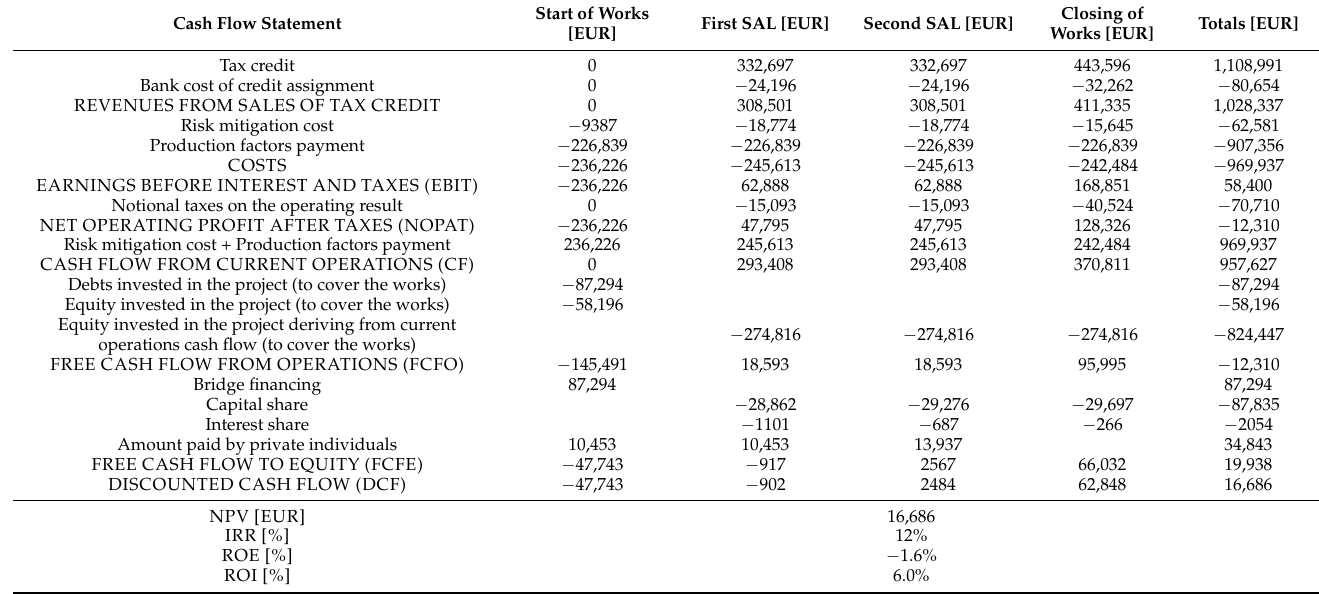
Table 11. Cash flow statement of the project in the event that critical levels similar to those found on small real estate units are assumed (most likely criticality mitigation